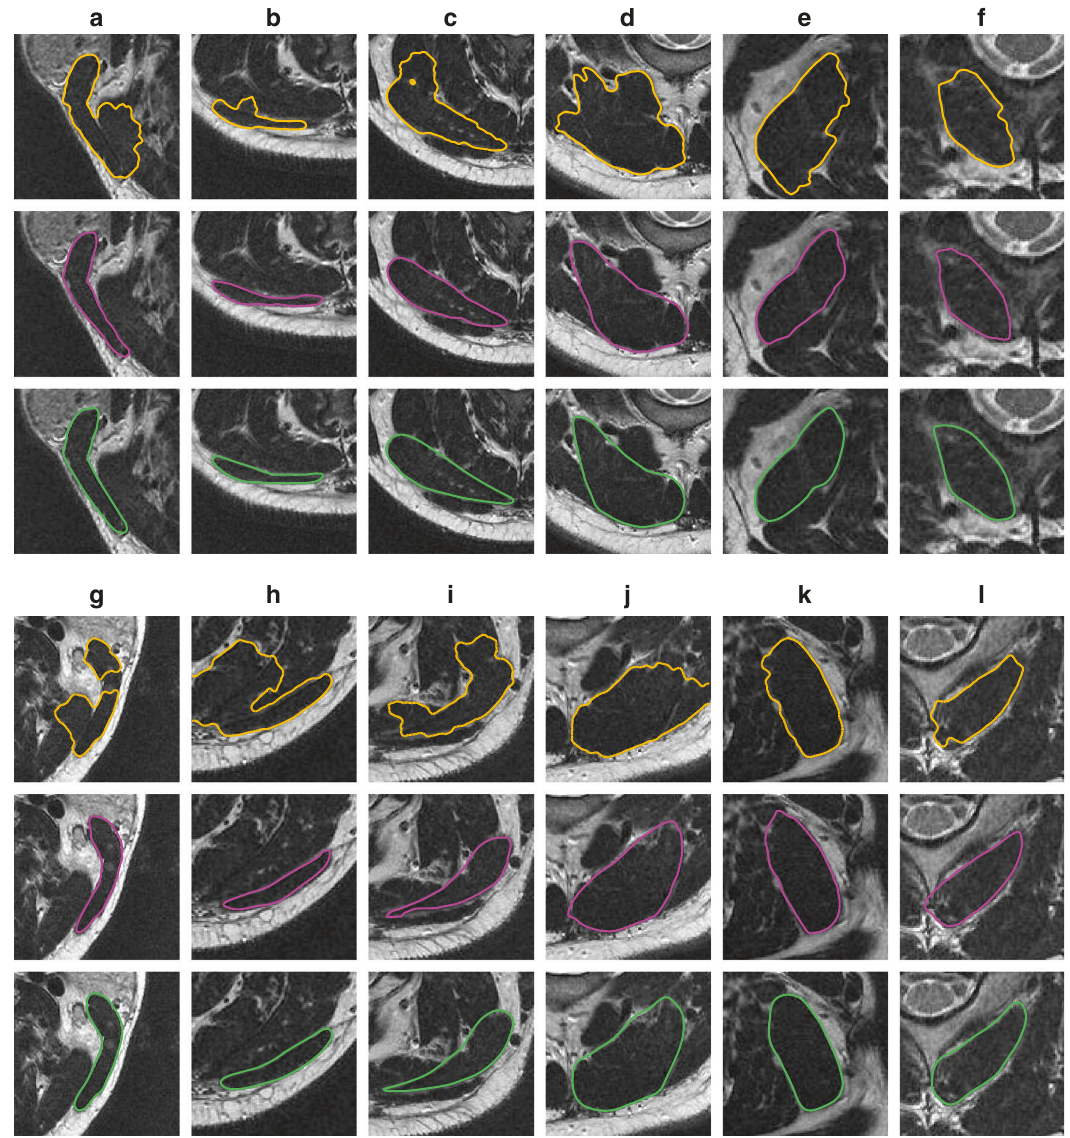
Fig. 7 Image-segmentation results for 12 head and neck muscles. Image columns from a to f are the muscles in the left region of the head, and image columns from g to l are the muscles in the right region of the head. Image columns from left to right: sternocleidomastoid (SCM), trapezius (TZ), splenius capitis (SC), semispinalis capitis (SSC), levator scapulae (LS), and obliquus capitus inferior (OCI). Yellow curves denote the boundaries obtained by the level-set algorithm DRLSE, magenta curves represent the contours segmented by the crack-propagation method, and green curves represent the manual segmentation